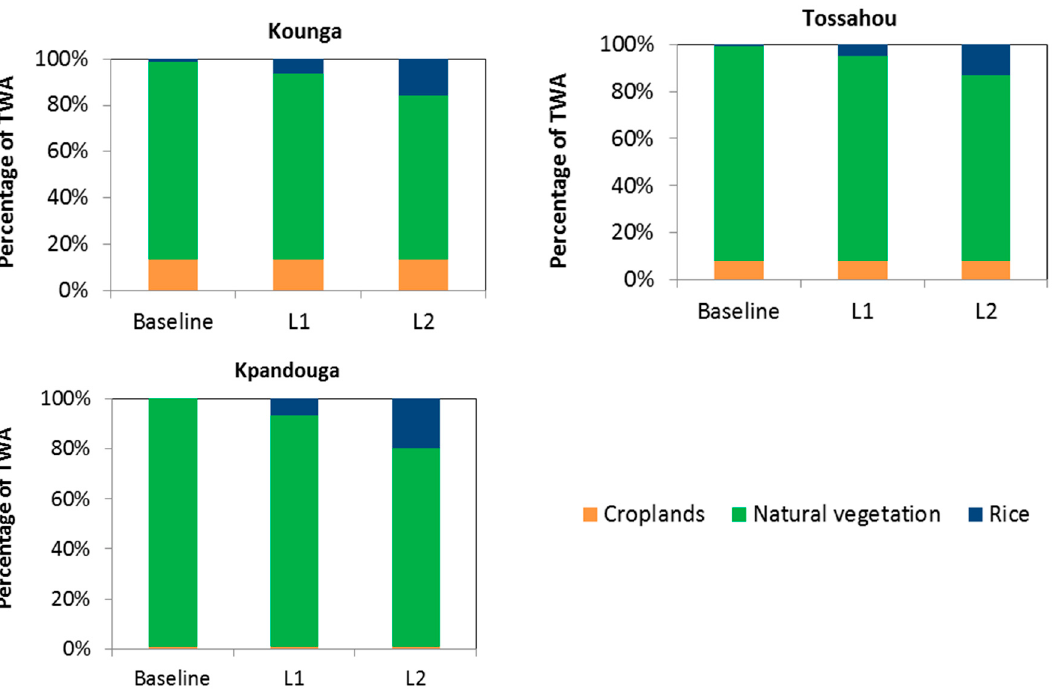
Figure 2. Percentage of land use types for the different land use scenarios in inland valley watersheds of Kounga, Tossahou and Kpandouga. TWA refers to total watershed area. L1 and L2 are land use change scenarios of 25% and 75% lowland conversion, respectively. Baseline refers to the baseline conditions of no vegetation land conversion into rice fields within the lowlands.